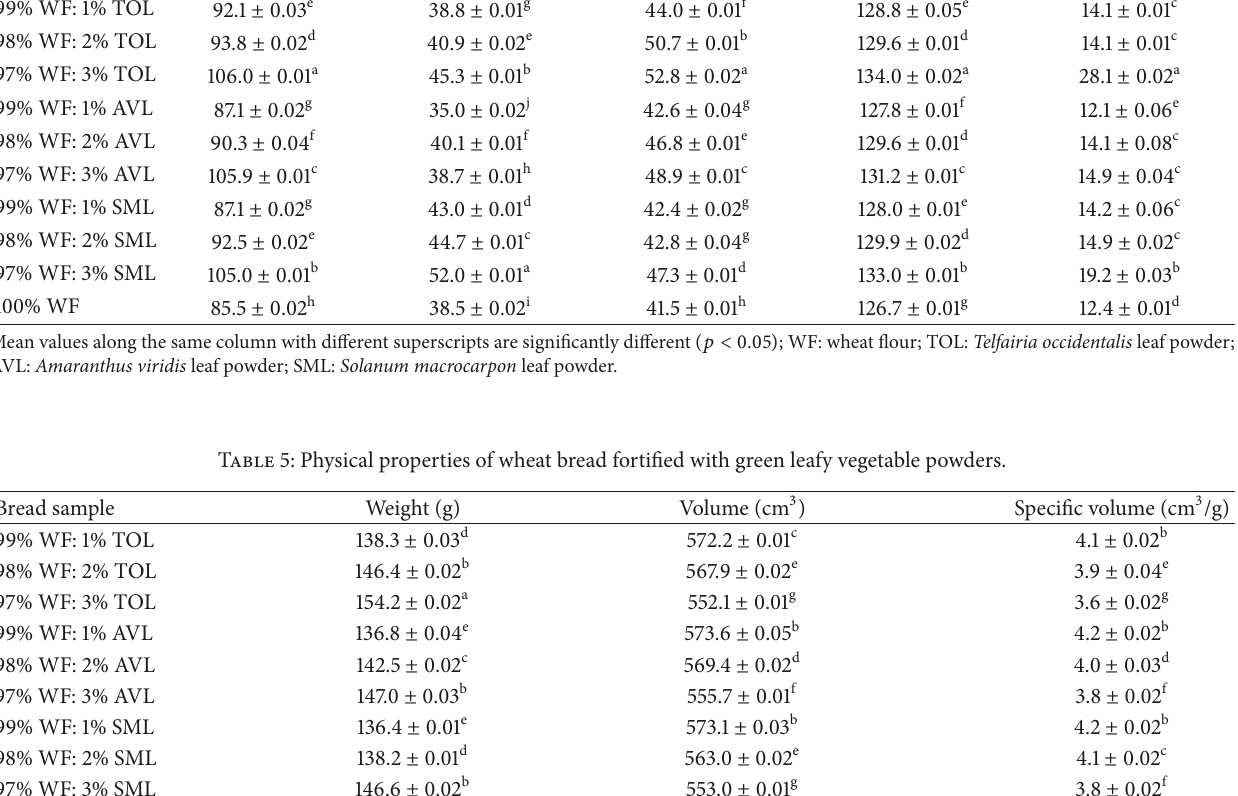
Table 4: Antioxidant properties of wheat bread fortified with green leafy vegetable powders. Bread sample